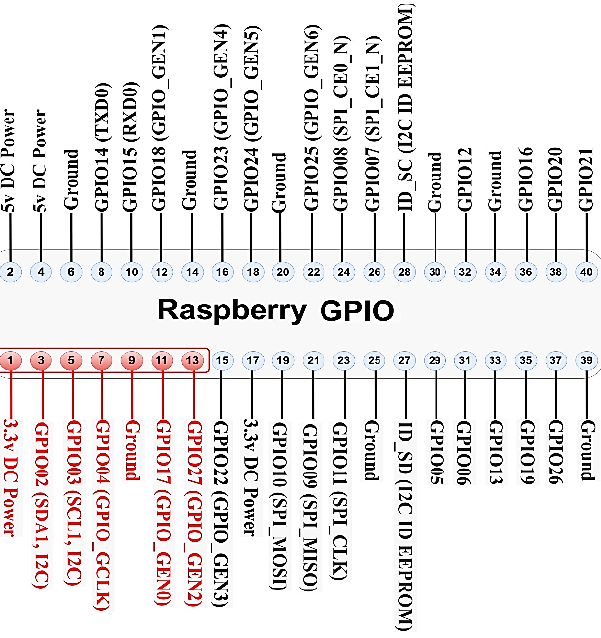
Figure 20. Multos Trust Core to pi GPIO.